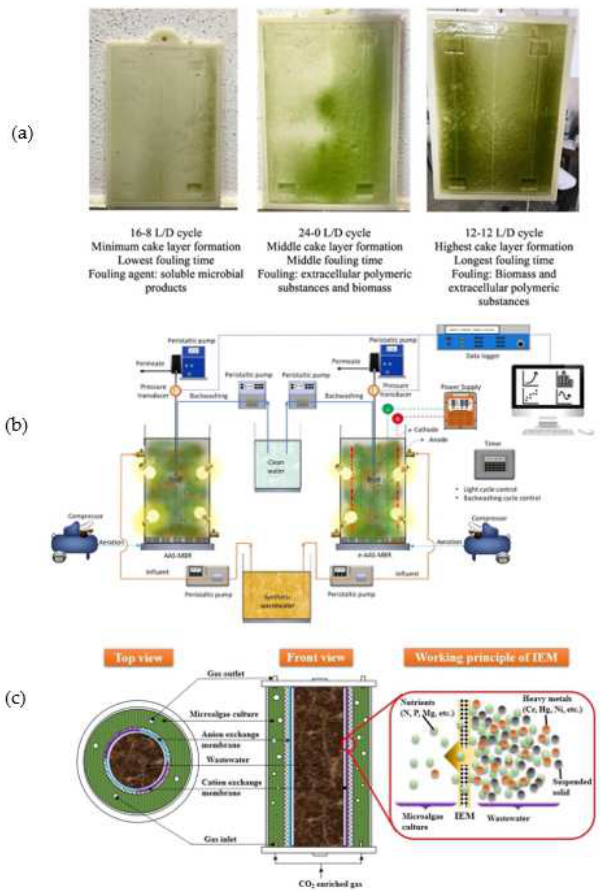
Figure 4. ( a ) The appearance of membranes operated in various light/dark (L/D) conditions. ( b ) Schematic illustration of conventional and electrically induced microalgae-activated sludge MPBR [133]. ( c ) Annular MPBR equipped with ion exchange membrane to separate microalgae cultivation and nutrient-containing wastewater [134] (Reprinted with permission).